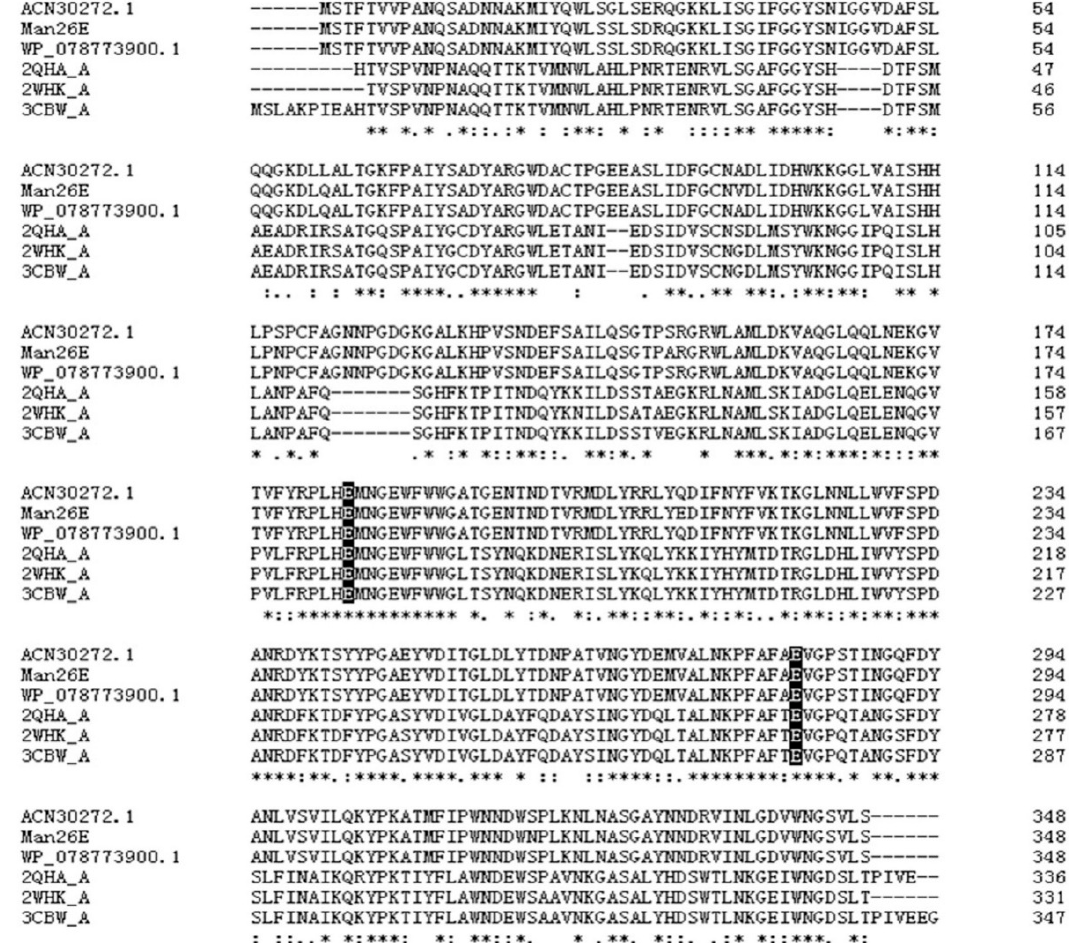
Figure 1. Multiple analysis of amino acid sequences of Man26E (GenBank accession no. ANA84055.1) with other mannan hydrolases. Man26E and the Genbank accession numbers and PDB ID of these hydrolases were listed on the left side of the figure. Identical, highly conserved (residues with strong similar properties), and conserved residues (residues with weak similar properties) among sequences are marked by asterisk (*), colon (:), and dot (.), respectively. The residues participate in catalytic action are marked as dark shade.